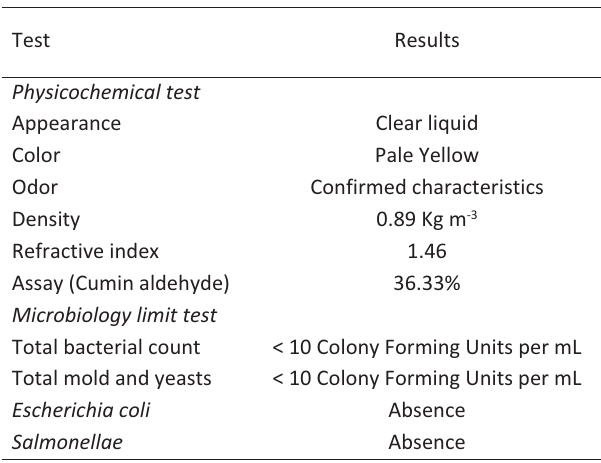
Table 1 ­ Physicochemical and microbiology of analysis of Cumin